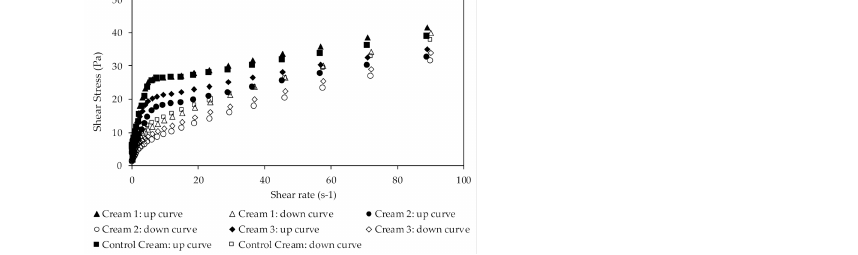
Figure 4. Flow curves obtained in the viscosity ramp up/ramp down assays from the extract- containing